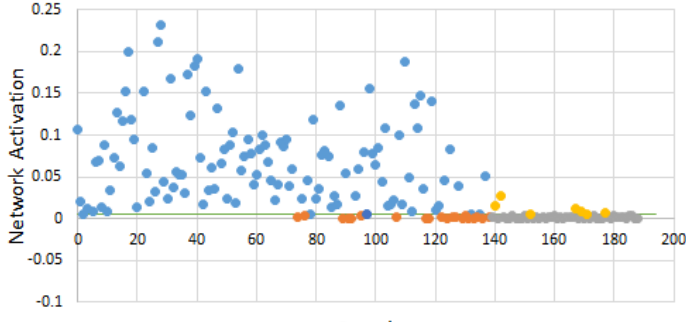
Figure 23. Activation values on network trained with UECFOOD100 dataset. Blue dots represent non-noisy food images. Orange dots represent food images classified as noisy samples. Grey dots show non-food images correctly determined as noisy samples. Yellow dots represent non-food images wrongly classified as non-noisy